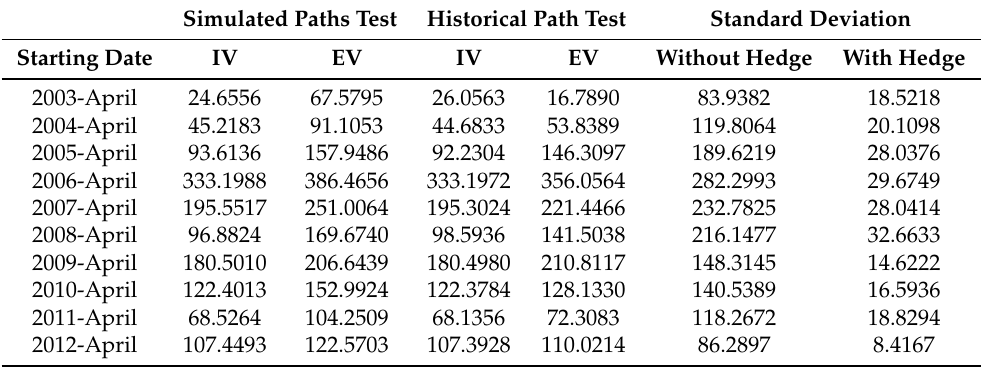
Table 6. Slow gas storage valuation (under spot model 2 (19)), in million of US dollars. Simulated Paths